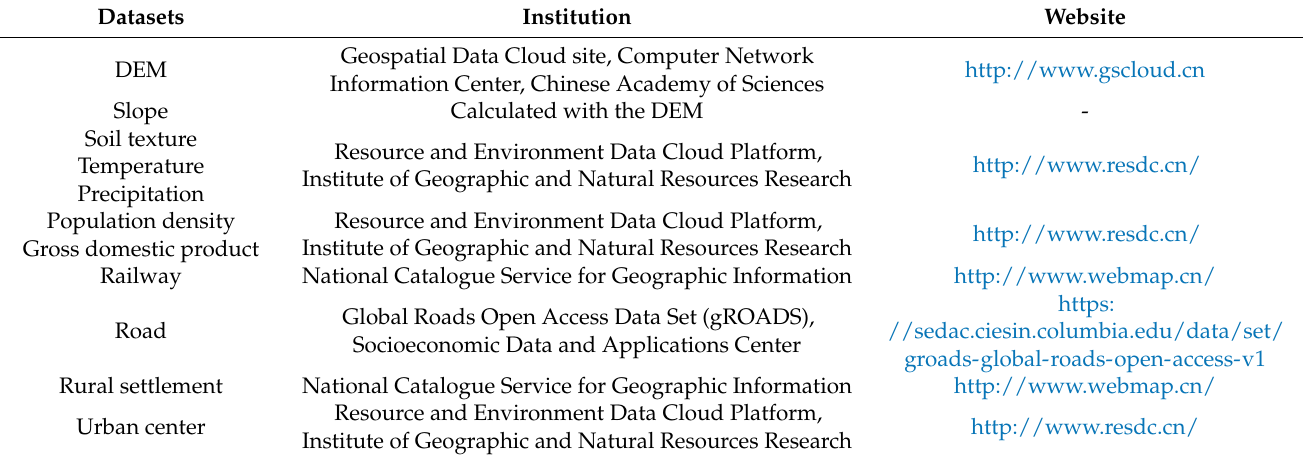
Table 1. Source of the datasets.